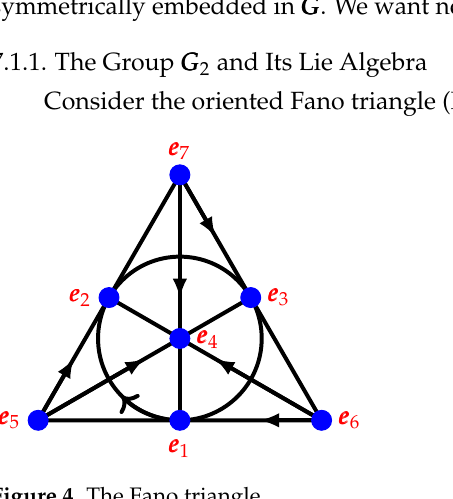
Figure 4. The Fano